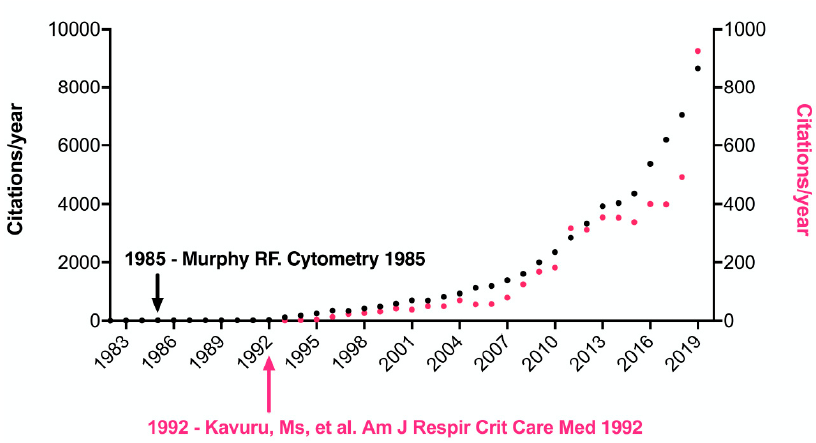
Figure 5. Citations on “Flow cytometry and respiratory diseases”. The annual number of citations in articles for the keyword ‘flow cytometry and respiratory diseases’ is represented by black dotted circles (Y-axis on the left side), and the number of citations per year for the keyword ‘flow cytometry and clinical diagnosis’ is presented by pink dotted circles (Y-axis on the right side), which have entered cytometry for diagnosis and follow-up since 1993. The data is generated from the Web of